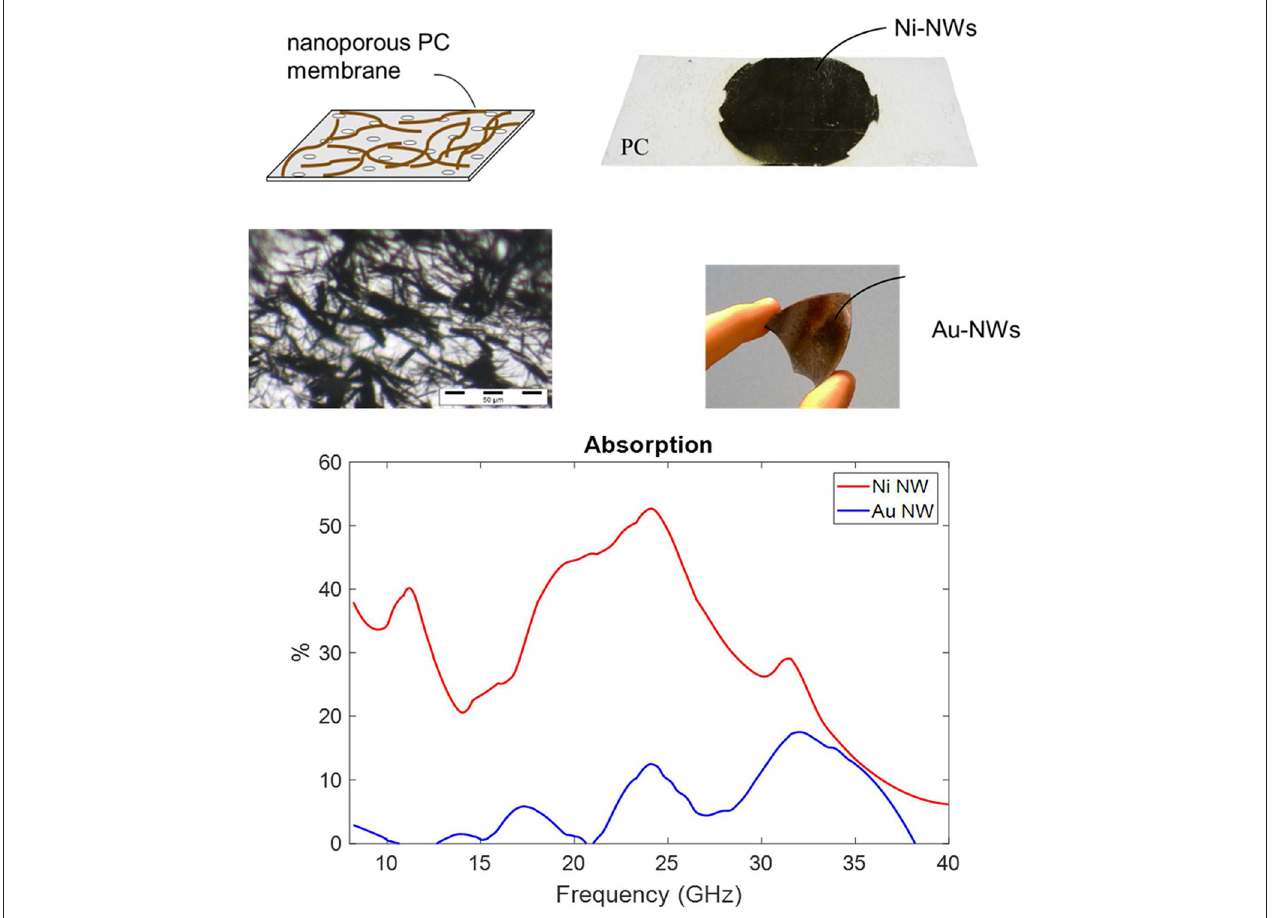
FIGURE 6 | Topology of metallic nanowires absorber; the NWs are collected on the filtering membrane in order to form the absorbing structure that is then inserted between two 55 µ m-thick Lexan TM polycarbonate films, and comparison between absorption induced by Ni-and Au-nanowires based-sandwich structures, respectively, obtained from Equation